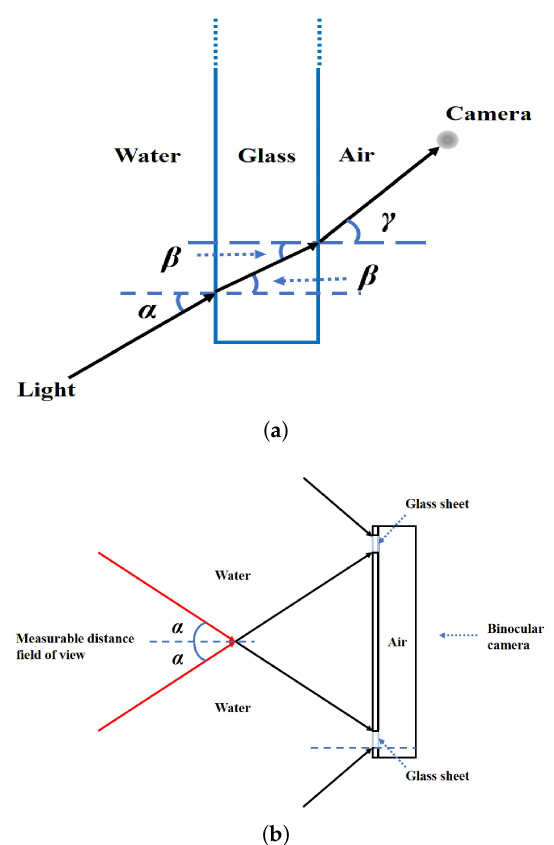
Figure 5. The diagram of refraction phenomenon on the binocular camera. ( a ) The diagram of the maximum incident angle to a certain edge. ( b ) The top view of the camera’s underwater visual